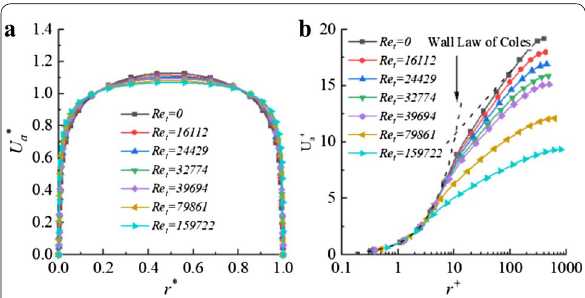
Figure 10 Axial velocity distribution with different Re t when Re a 13777: ( a ) Axial velocity normalized by Eqs. (11) and (12); ( b ) = Axial velocity nondimensionalized by Eqs. (6) and (8)